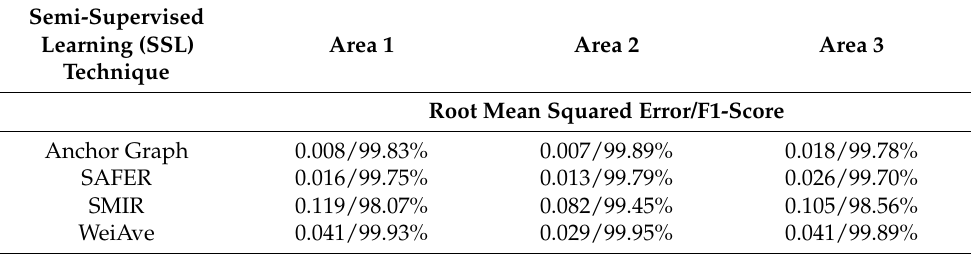
Table 4. Evaluation of the performance of the proposed Semi-Supervised Learning (SSL) techniques to estimate the actual targets (labels) of the unlabeled